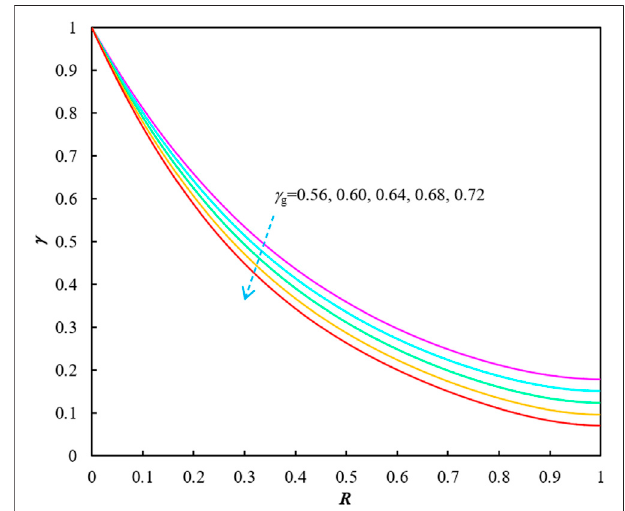
FIGURE 3 | The effects of gas gravity on c vs. R relationships ( p i (cid:1) 70 MPa and T (cid:1) 90 °